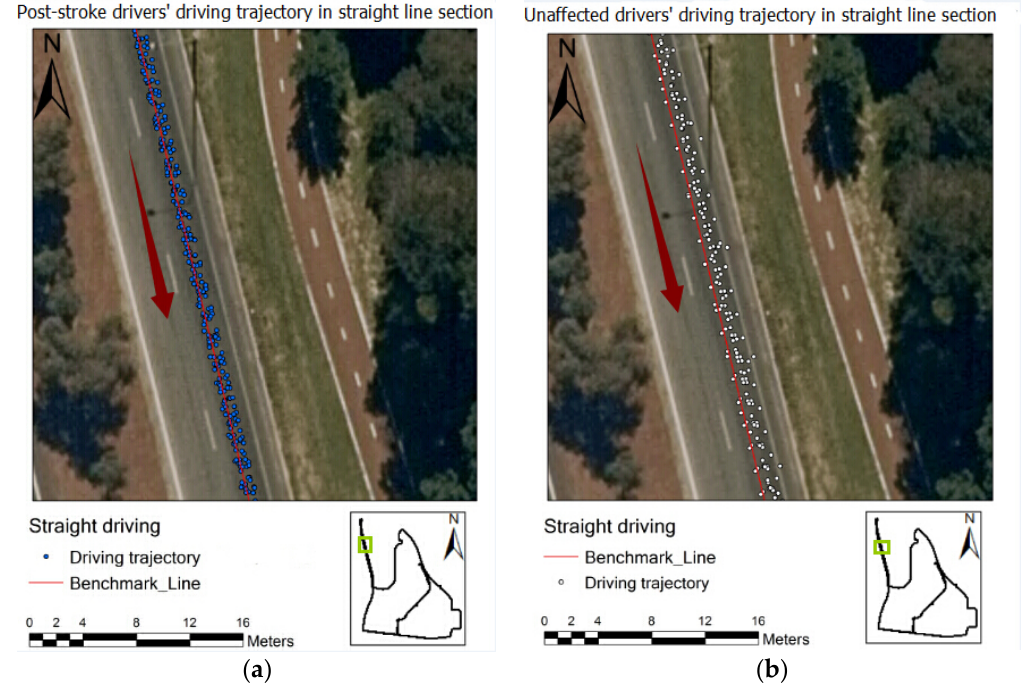
Figure 3. Driving trajectory of post-stroke ( a ) and normal ( b ) groups in a straight line.